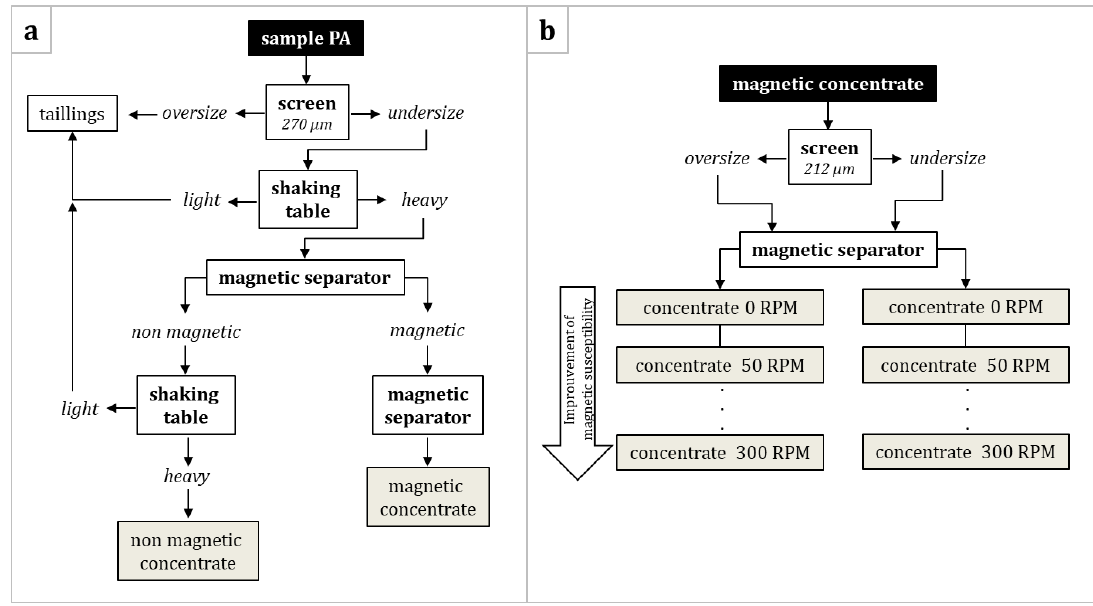
Figure 4. Main recovery test flow sheet ( a ) and differential magnetic separation flow sheet ( b ).